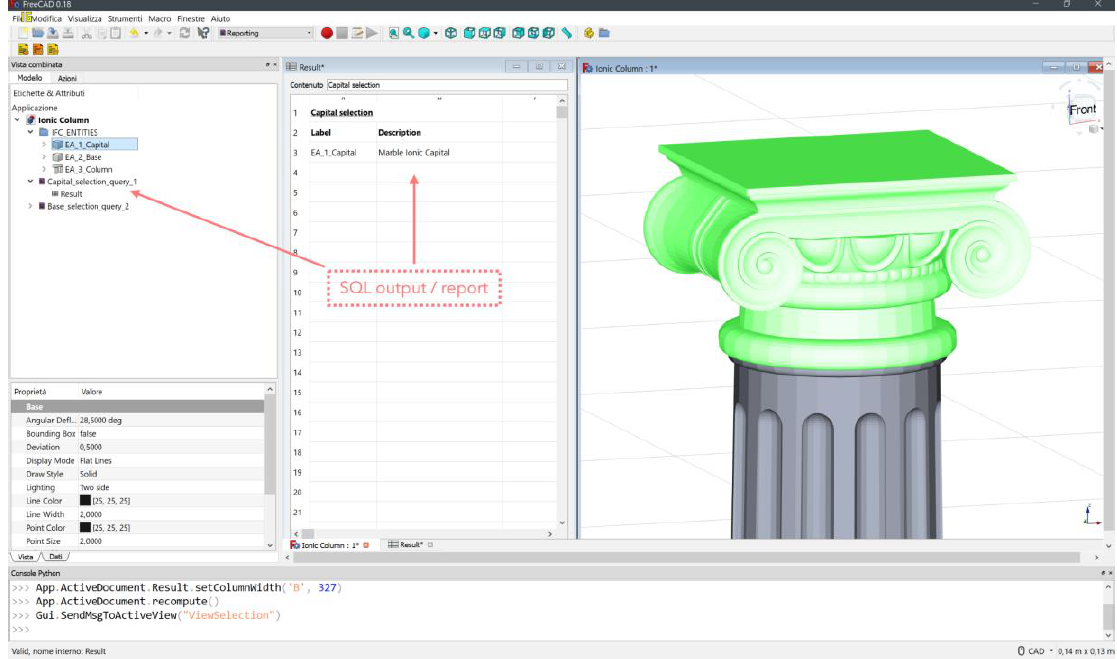
Figure 14. SQL query in order to investigate Capital IFC custom role: on the left side are the saved capital_selection_query_1 and the related datasheet report with the query result.